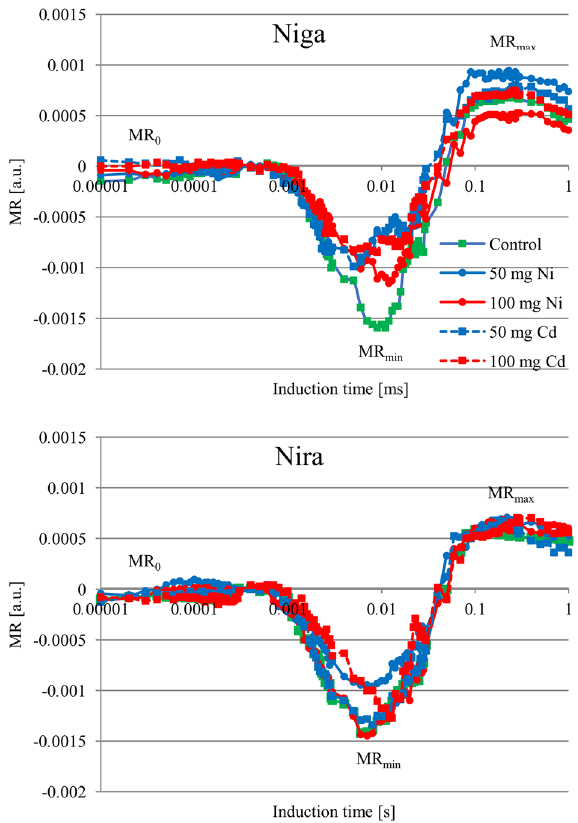
Figure 5. Kinetics of modulated light reflection at 820 nm [relative units, all data are normalized to the initial measured value of the signal] of two perennial ryegrass turf cultivars (‘Niga’ and ‘Nira’) under different Ni and Cd treatment (0; 50 and 100 mg × 100 g −1 of substrate) (n = 6).